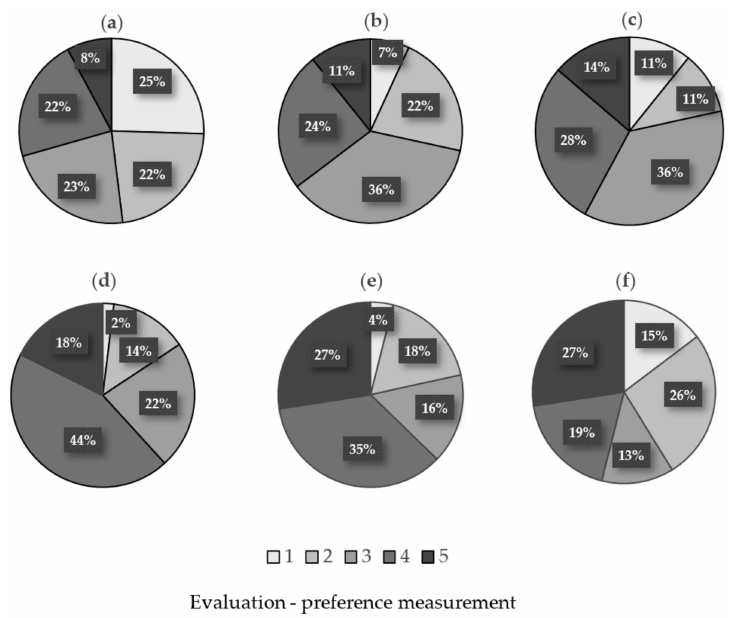
Figure 16. The percentage distribution of the preferences for the individual shades of the samples—solid birch wood. ( a ) Solid wood—untreated; ( b ) solid wood—treated at 160 ◦ C / 3 h; ( c ) solid wood—treated at 170 ◦ C / 3 h; ( d ) solid wood—treated at 180 ◦ C / 3 h; ( e ) solid wood—treated at 190 ◦ C / 3 h; ( f ) solid wood—treated at 200 ◦ C / 3